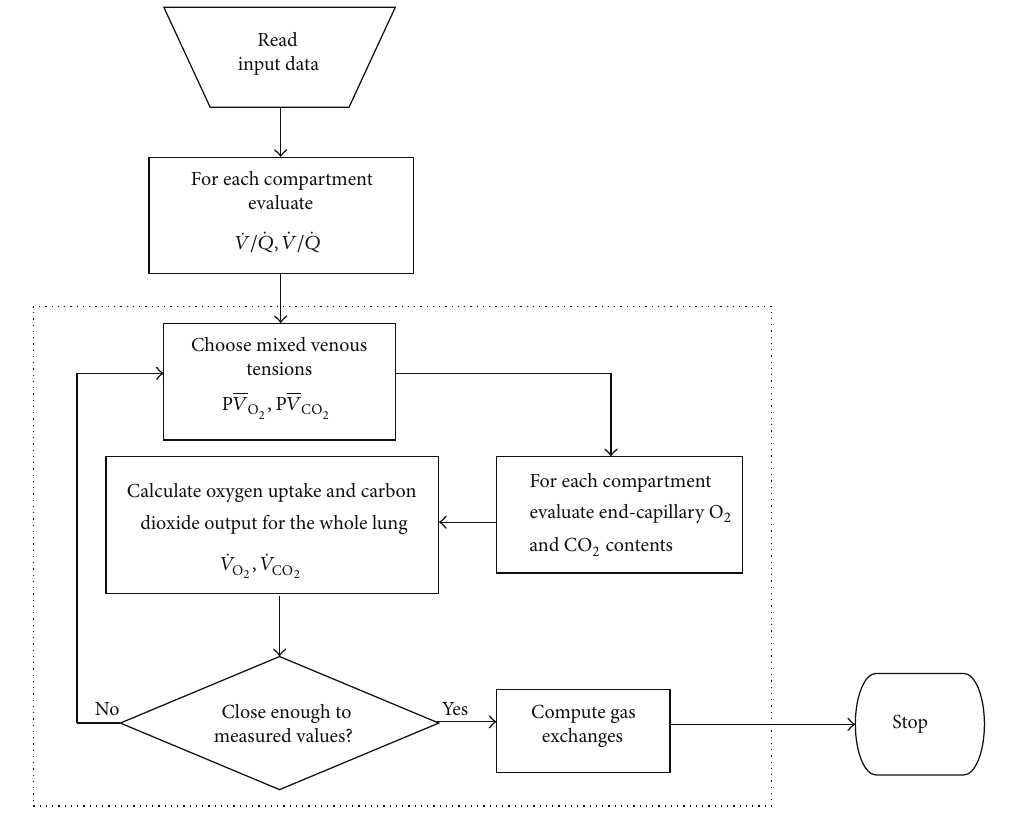
Figure 1: Algorithm for the noninvasive assessment of pulmonary gas exchange (Hanky Hapy gas analyzer version 1.2).